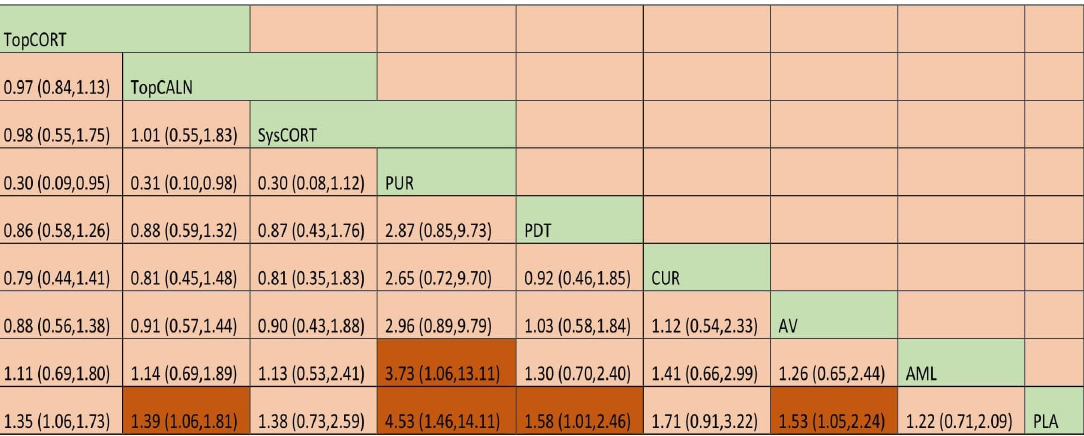
Figure 3. Network plot: Clinical Improvement of Oral Lichen Planus. Abbreviations: AML, amlex ‐ anox paste; AV, aloe vera; CUR, curcumin gel; PDT, photodynamic therapy; PLA, placebo; PUR, purslane; SysCORT, systemic corticosteroid; TopCALN, topical calcineurin; TopCALNcoSysCORT, topical calcineurin combined with systemic corticosteroid; TopCORT, topical corticosteroid.